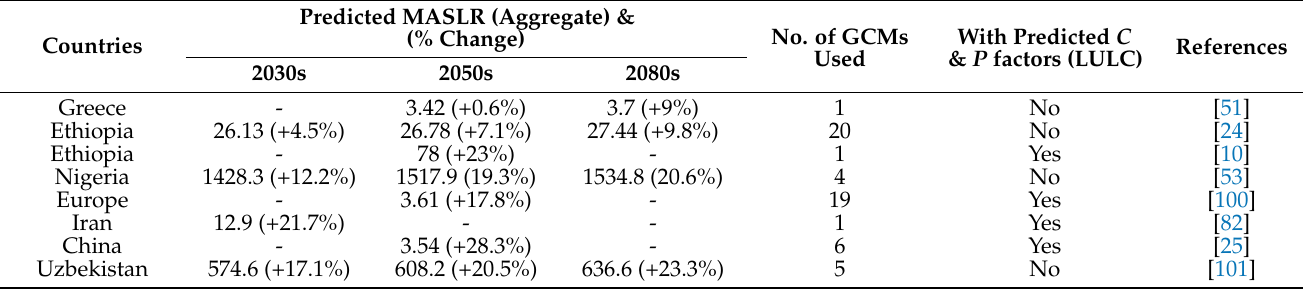
Table 19. Predicted mean soil erosion rates (t ha − 1 yr − 1 ) and percentage change from the respective baseline soil erosion rates for different countries around the world. Predicted MASLR (Aggregate) & (% Change) No. of GCMs Countries